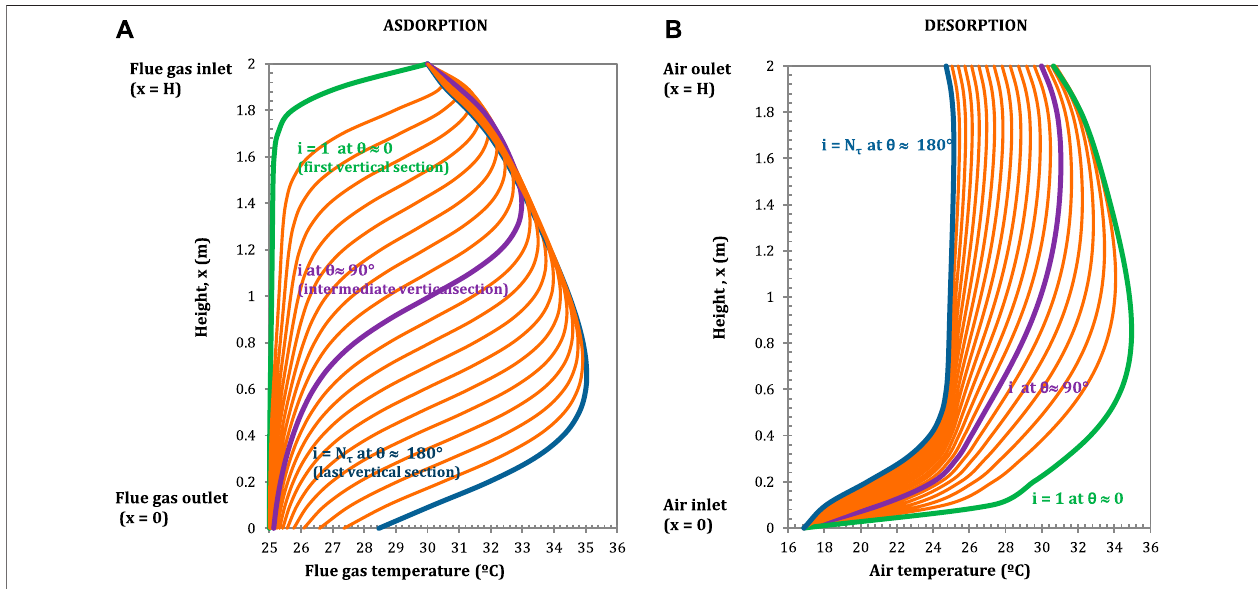
FIGURE 6 | Temperature pro fi les in the fl ue gas (A) (adsorption) and in the air, (B) (desorption) in longitudinal direction for each vertical section. Con fi guration: S-EGR in parallel at 70% recirculation ratio. Adsorbent: Activated Carbon.